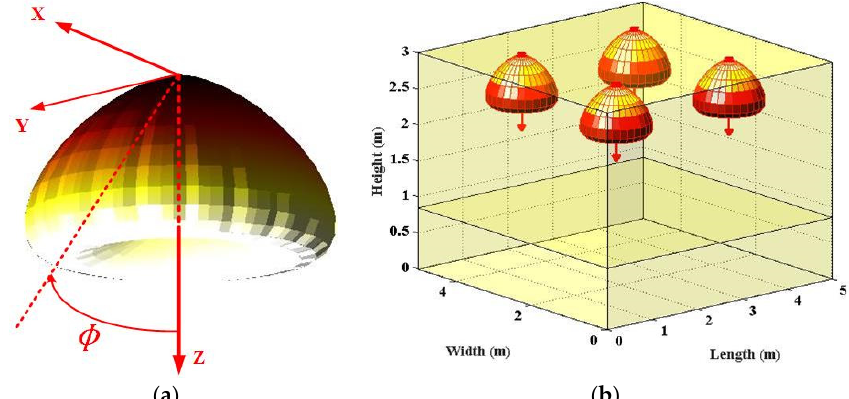
Figure 2. ( a ) 3D spatial optical beam of LUXEON Rebel non-Lambertian LED; ( b ) LUXEON Rebel non-Lambertian LED-applied indoor scenario, respectively.